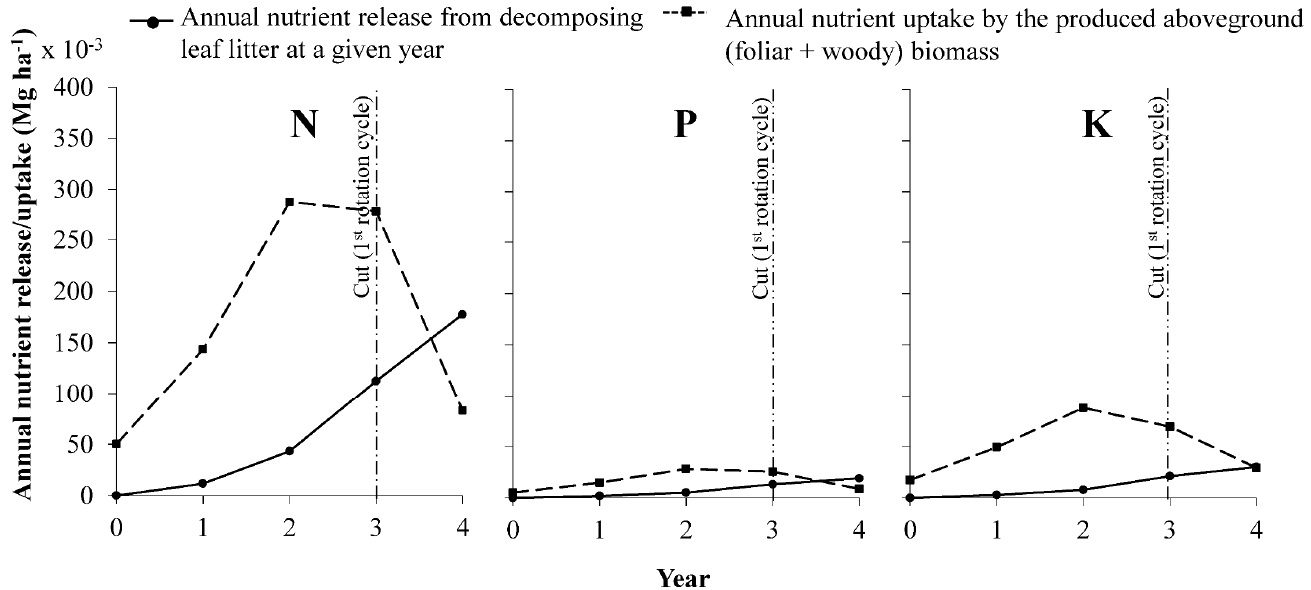
Figure 4. Balance between the release of nutrients into the environment through leaf litter decomposition and the nutrient uptake by the aerial biomass.